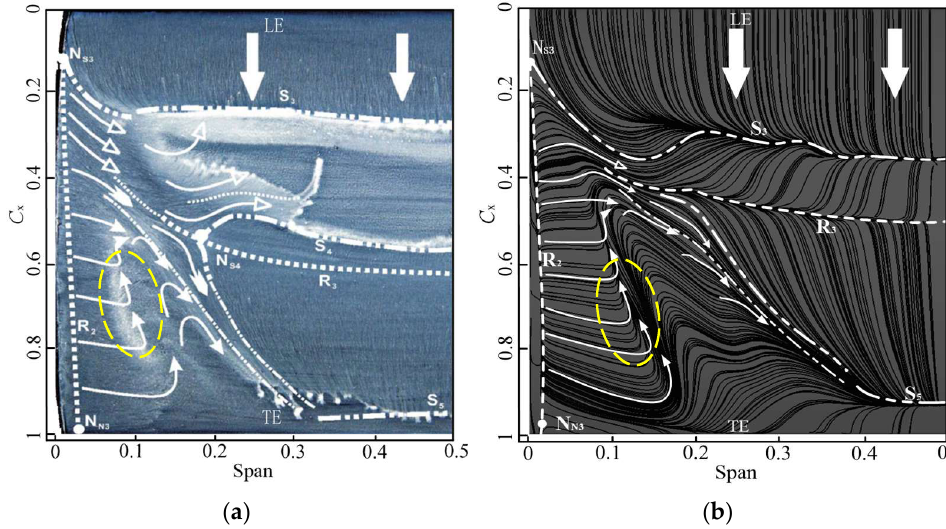
Figure 6. Flow field on the suction surface at i = −1°. ( a ) Experiment result [3]; ( b ) CFD result.